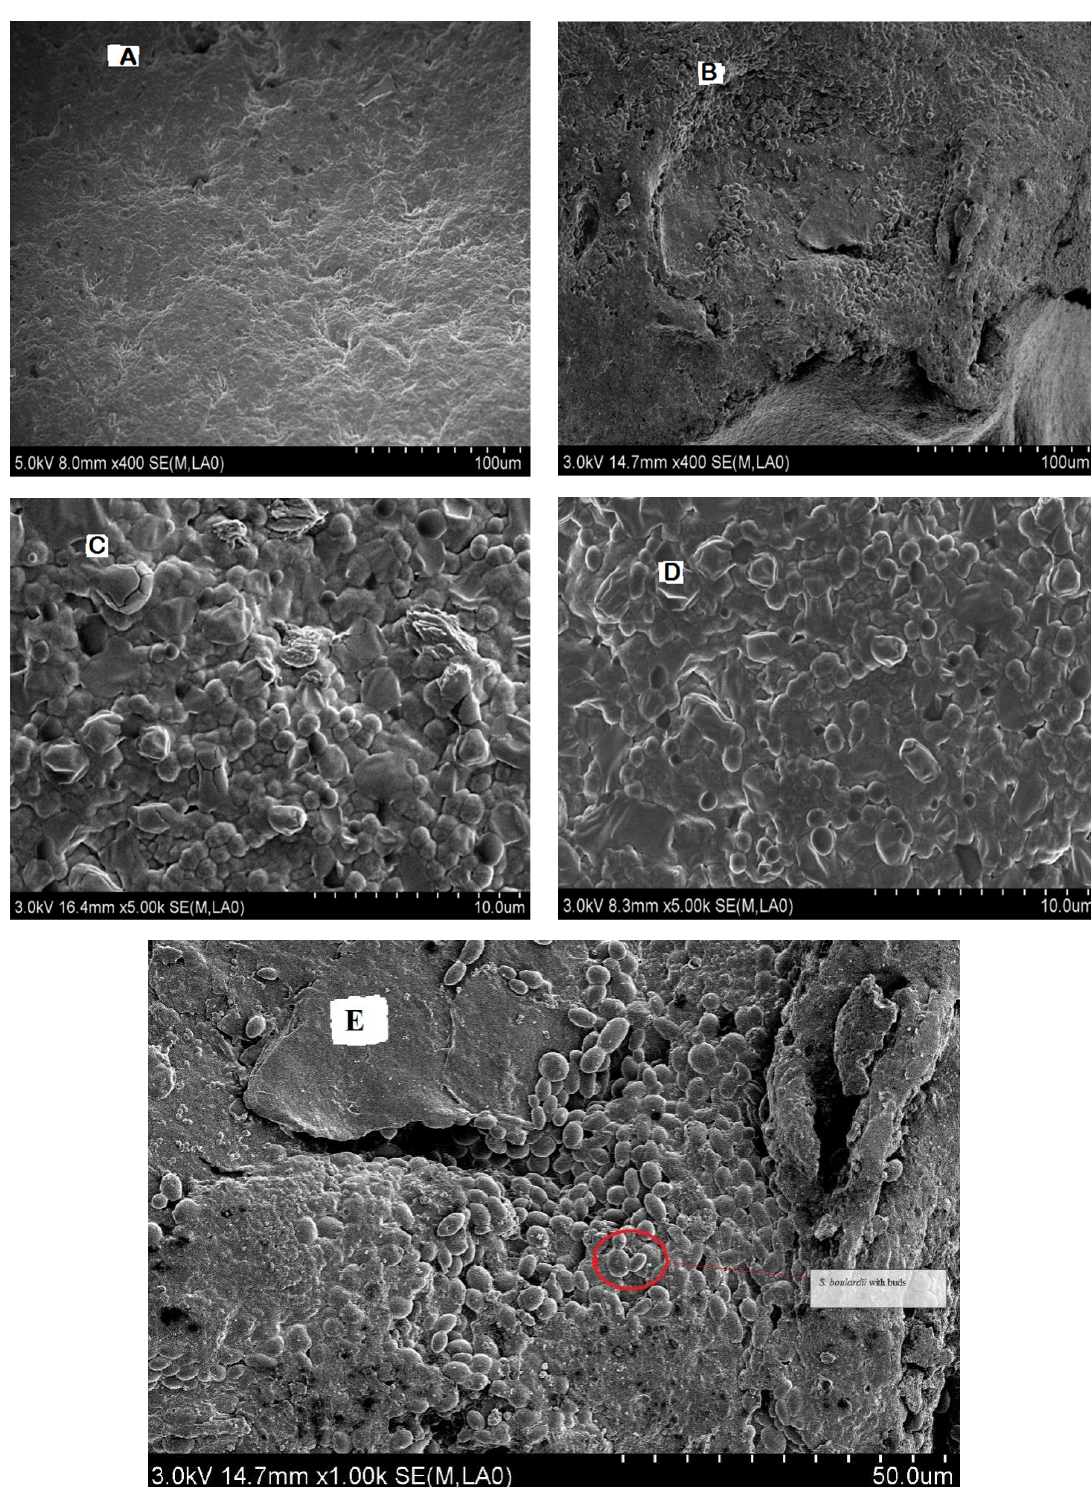
Figure 4. Scanning electron microscope images at low (400 × ) and high (5000 × ) magnifications of the control plain yogurt sample S1 ( A , C ) and synbiotic yogurt sample S3 with 0.5% S. boulardii + 1% inulin ( B , D , E ).